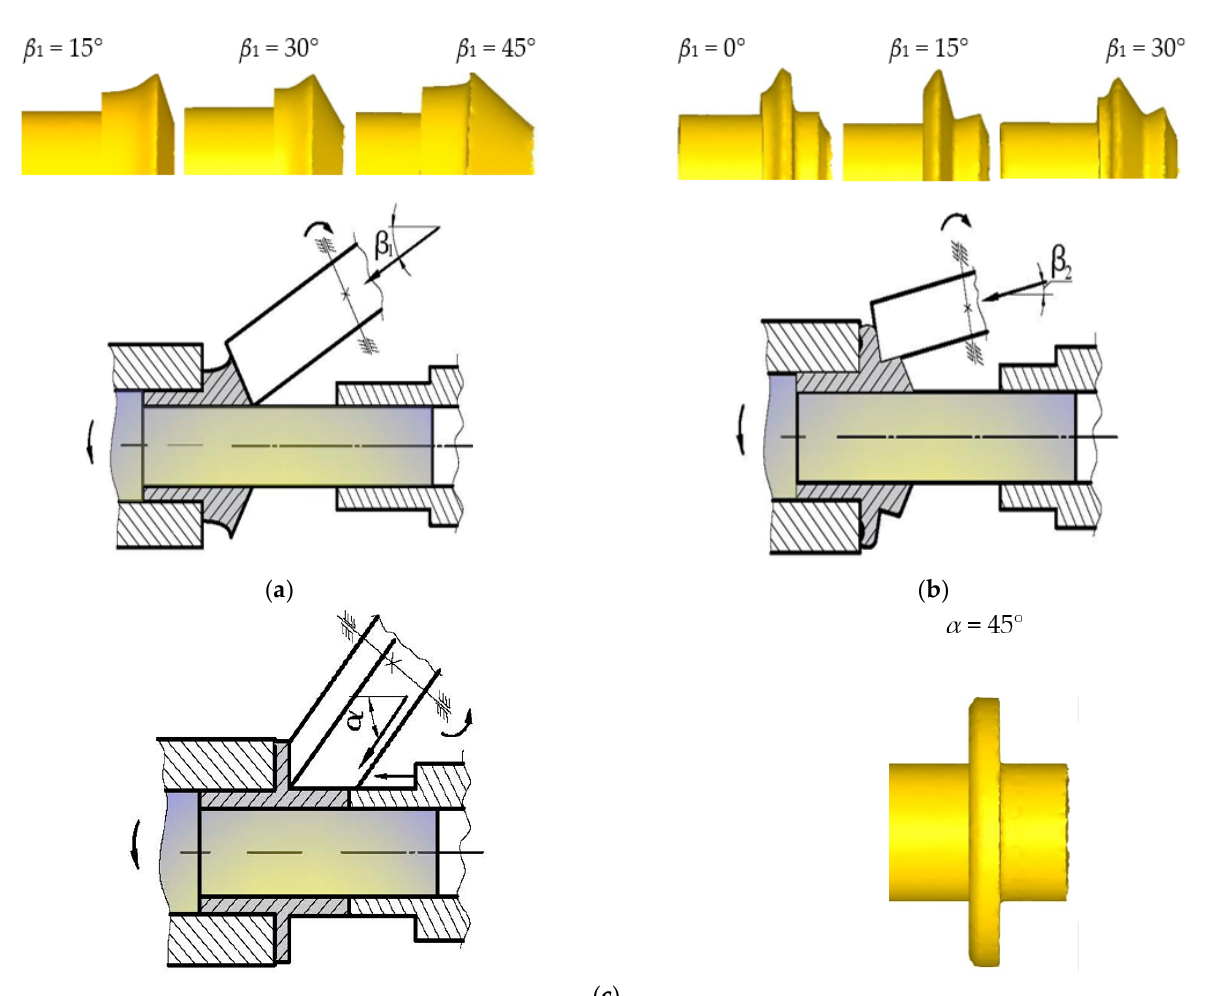
Figure 5. The sequence of flange part formed by angular rolling: ( а – c ) the first, second, and third stages of shaping.